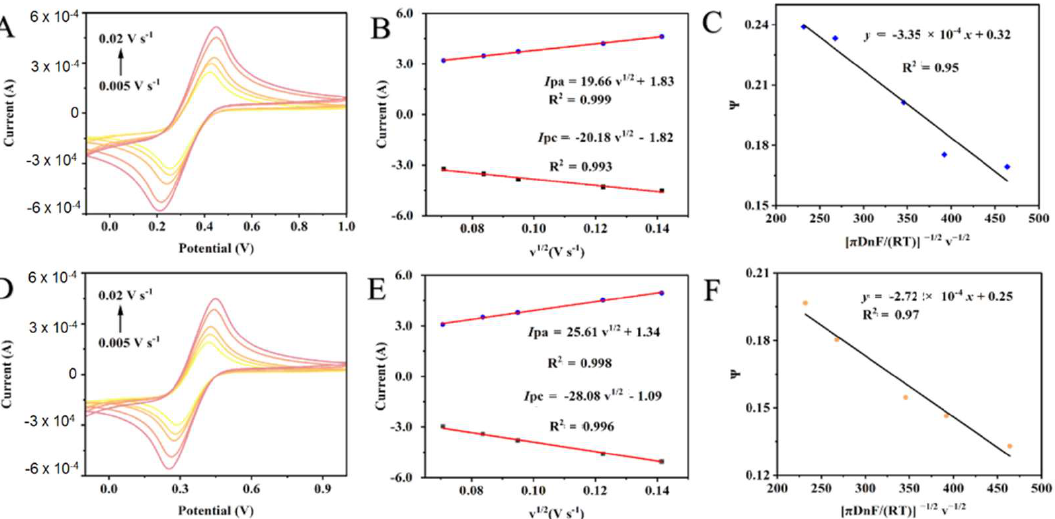
Figure 2. The cyclic voltammetry (CV) curves of the bare electrode ( A ) and the g-C 3 N 4 -CdS-CuO modified electrodes ( D ) at different scan rates (0.005~ 0.02 V/s), and bare electrode ( B ) and the g- C 3 N 4 -CdS-CuO modified electrodes ( E ) of linear relationship between the anodic and cathodic peak currents versus the square of the root of the scan rate, the plots of ϕ values vs. [ π DnF/(RT)] − 1/2 υ − 1/2 : ( C ) the bare electrode and ( F ) the g-C 3 N 4 -CdS-CuO modified electrodes.